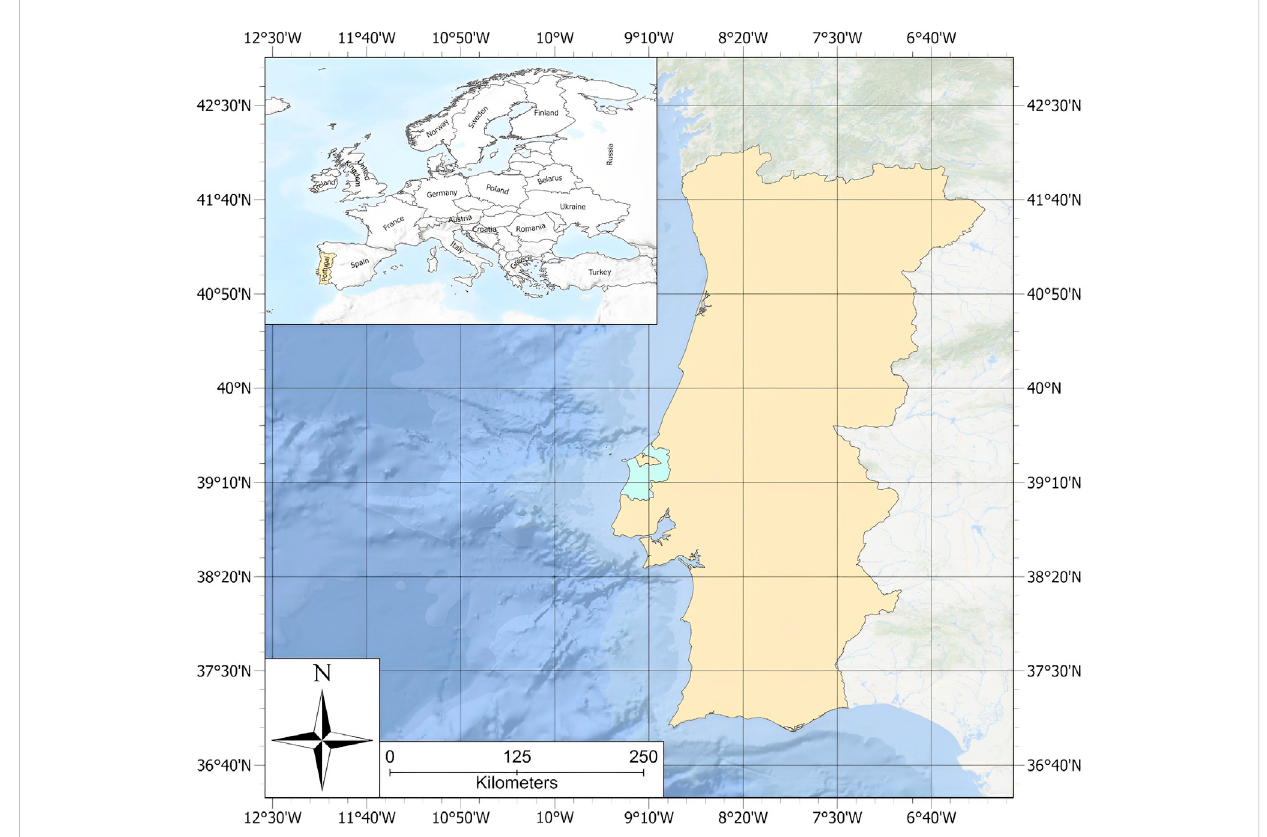
FIGURE 1 Location of the aspiring Oeste Geopark. Source: fi le made available by the aspiring Oeste Geopark team (2021).